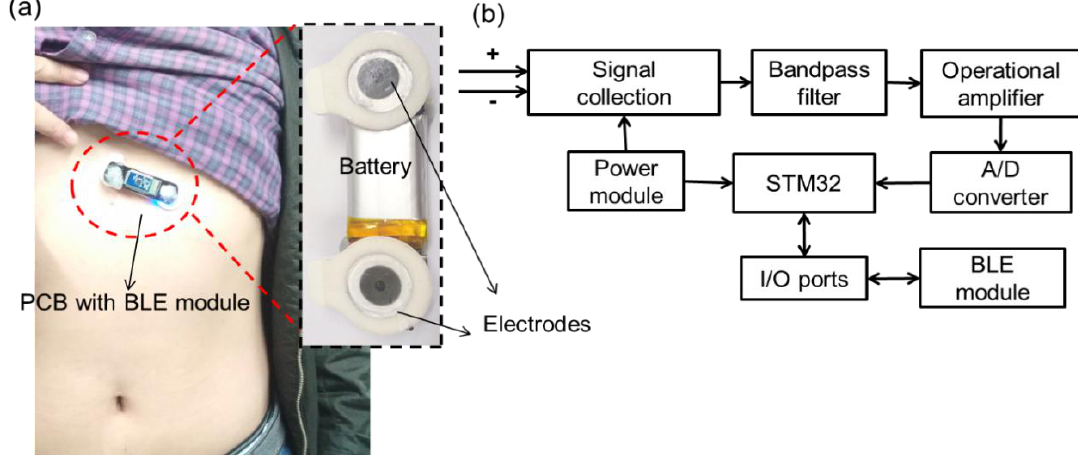
Figure 1. Overall architecture of the wearable electrocardiogram (ECG) monitoring system: ( a ) ECG device placed on the side area of the chest and the lower right rib area (10th rib bone); ( b ) working flowchart of the ECG hardware.